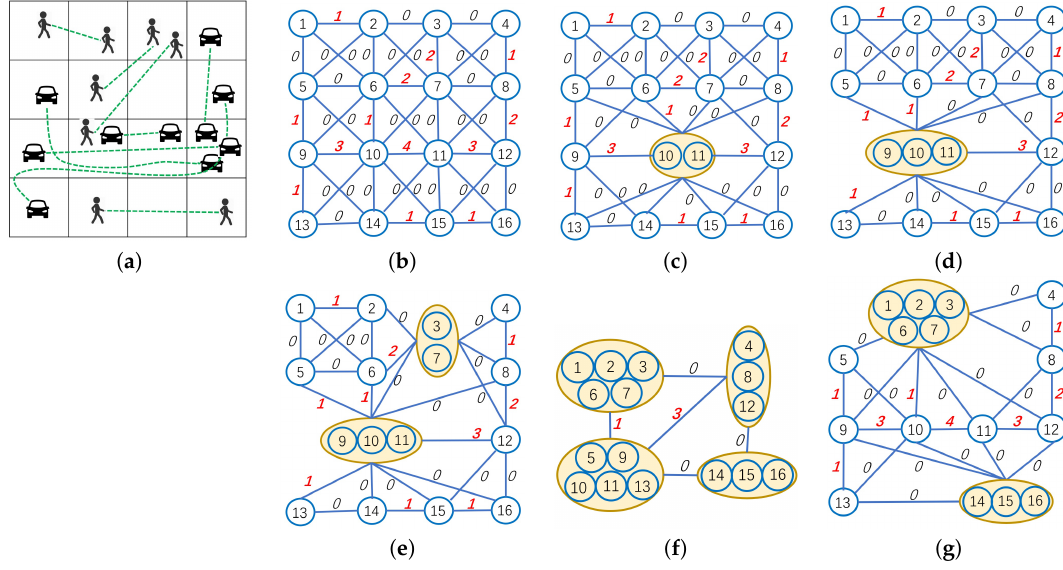
Figure 2. A demo example for Algorithm